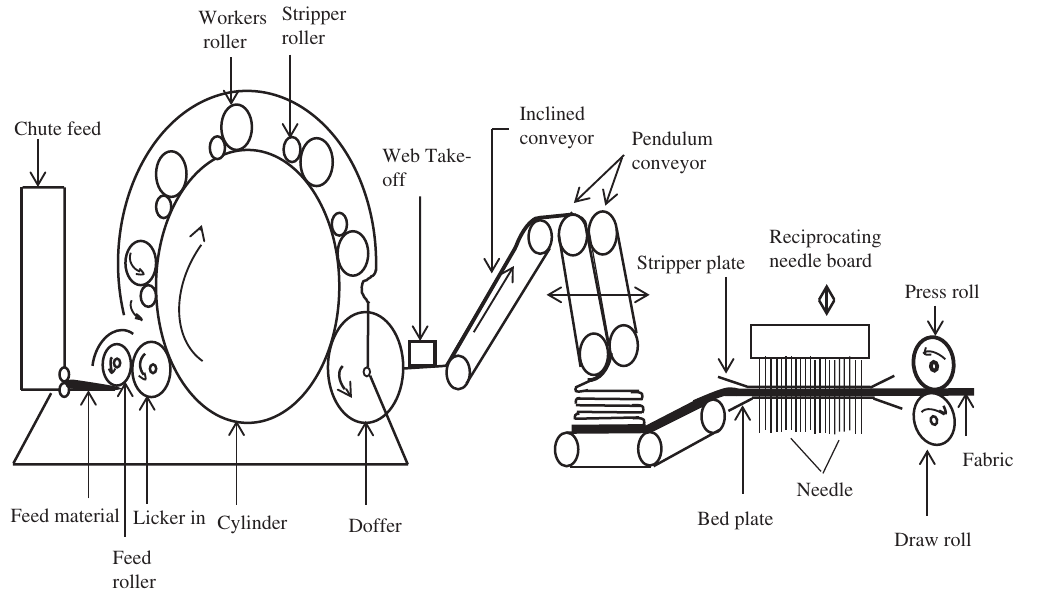
Figure 1: Schematic diagram of needle punching nonwoven machine.